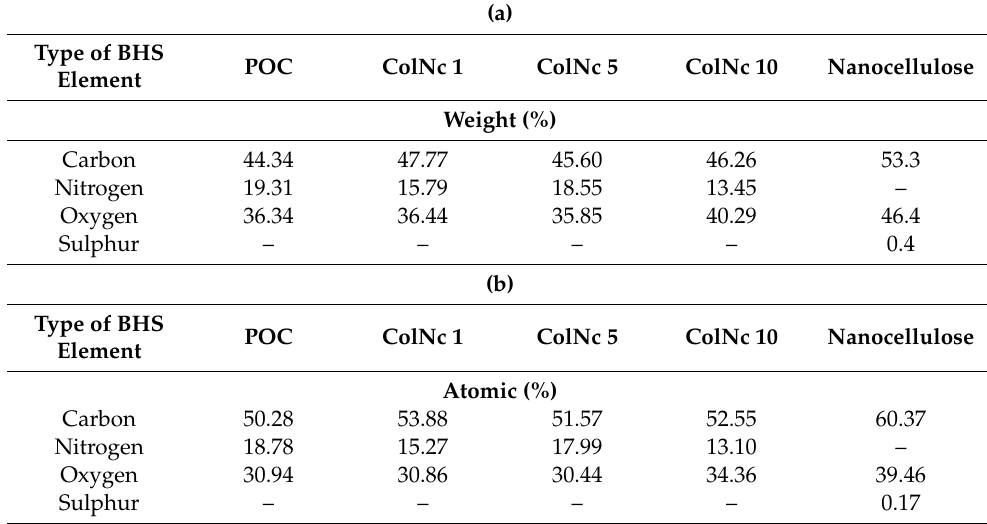
Table 1. Elemental analysis by EDX where ( a ) shows percentage by weight and ( b ) shows percentage by atomic. Elements detected in both POC and BHS sca ff olds were carbon, oxygen, and nitrogen with carbon being the most abundant element. Whereas, elements detected in nanocellulose were carbon, oxygen and